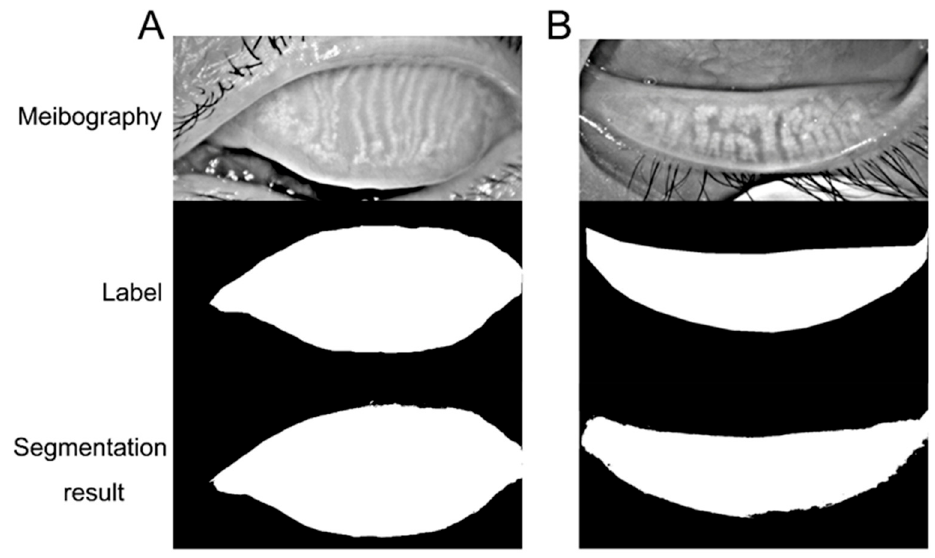
Figure 4. ( A ): The representative of meibography, label, and segmentation results for upper lid tarsus; ( B ): The representative of meibography, label, and segmentation results for lower lid tarsus.